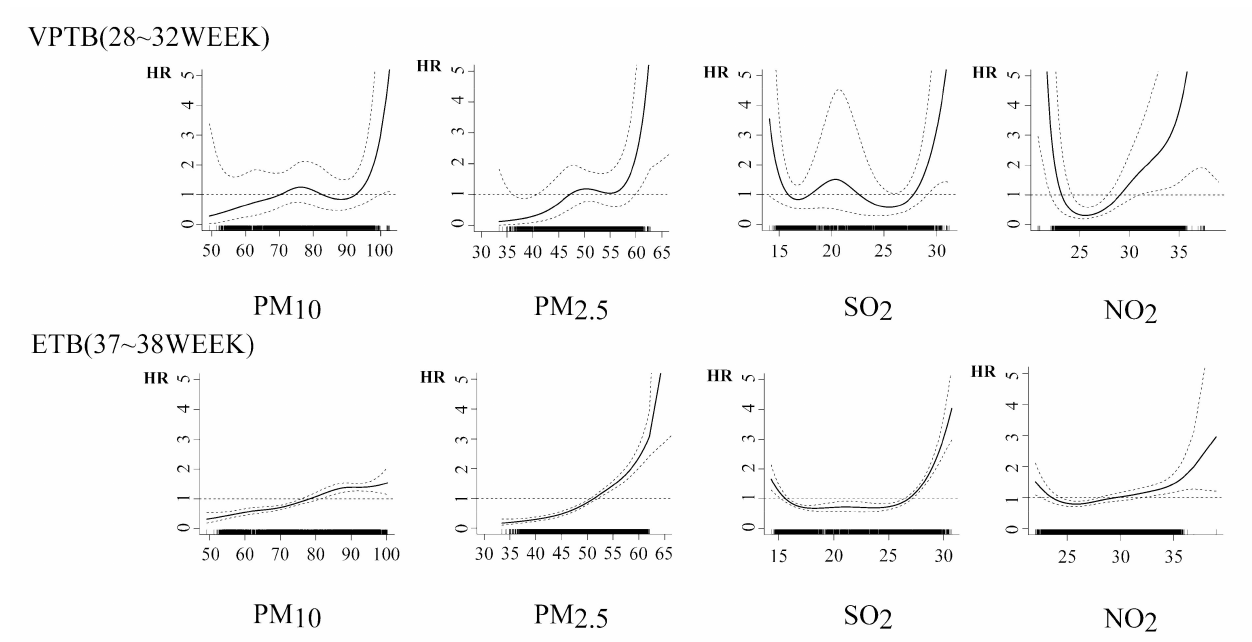
Figure 3. The concentration–response curves of different pollutants ( µ g/m 3 ) during the whole